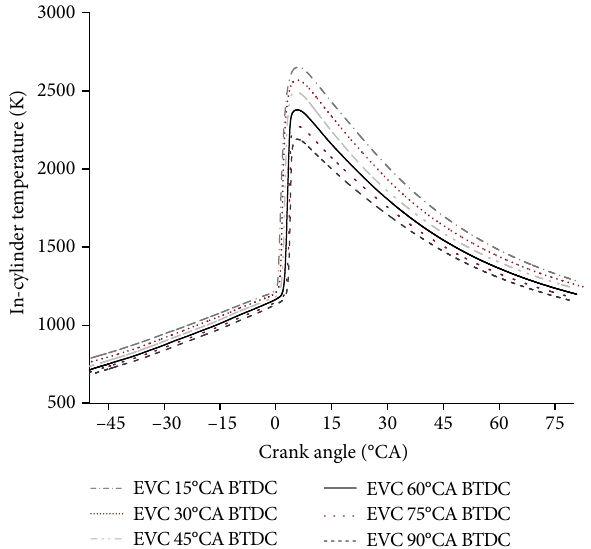
Figure 10: In fl uence of advanced EVC on heat release rate.